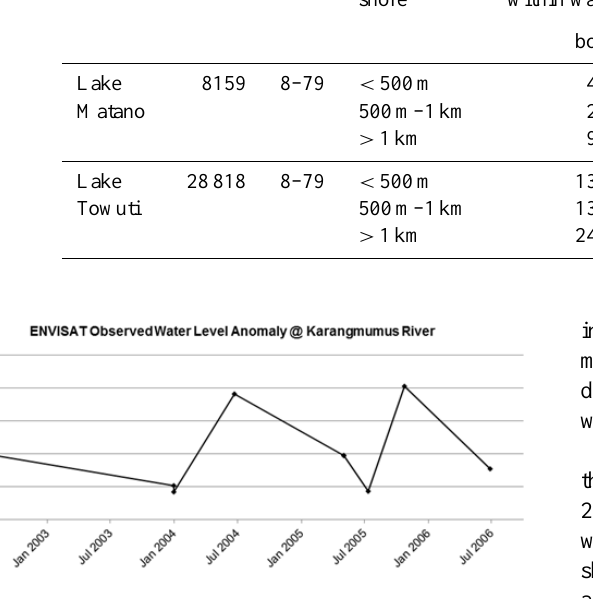
Figure 11. Water level anomaly of the Karangmumus River from Envisat RA-2, processed by Ice-1